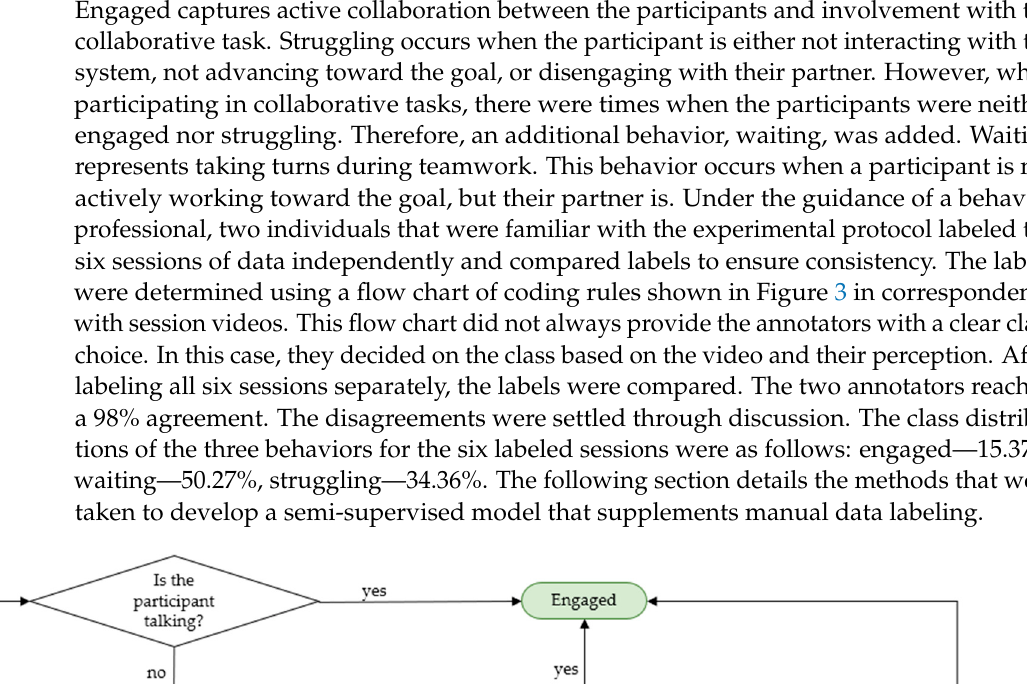
Figure 4. Semi-supervised self-training algorithm.